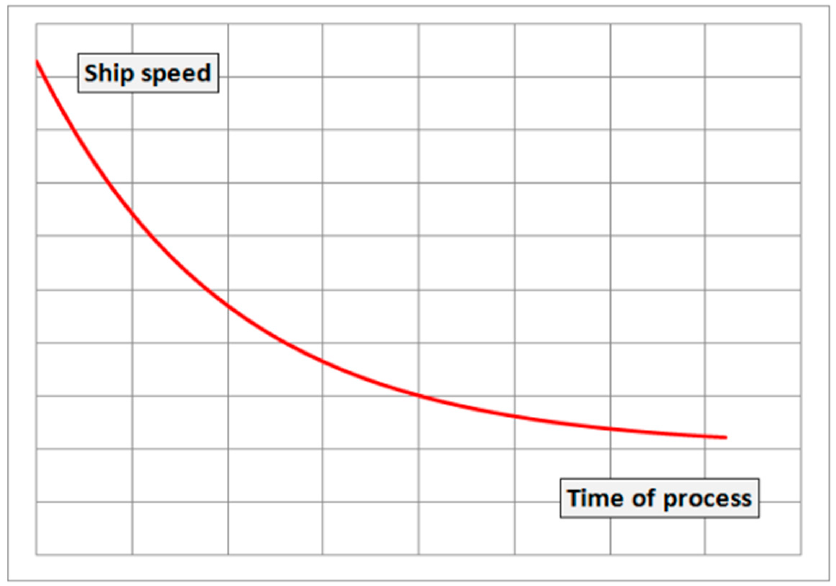
Figure 11. Icebreaker speed dropping while overcoming ridges astern.